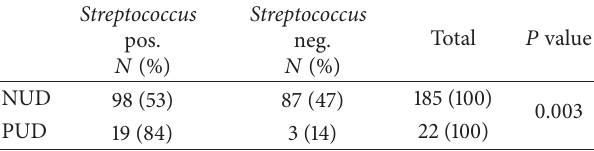
Table 9: Prevalence of Streptococcus sp. according to disease